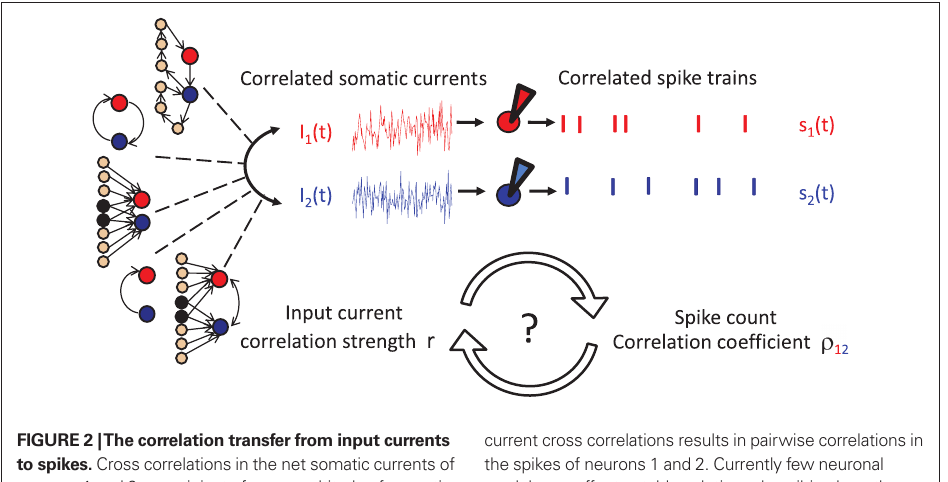
Figure 2 | The correlation transfer from input currents to spikes. Cross correlations in the net somatic currents of neurons 1 and 2 can originate from a multitude of synaptic interactions: direct or recurrent synaptic connections, common inputs or their combination. The presence of